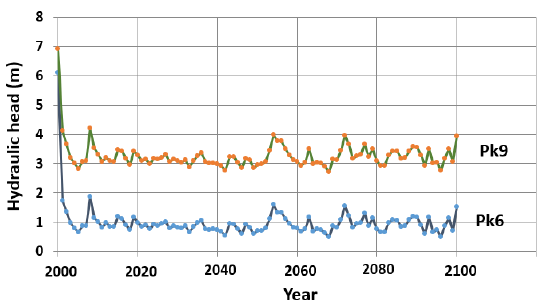
Figure A11. Concentrations variation at wells Pk6 and Pk9 under RCP scenario 8.5.